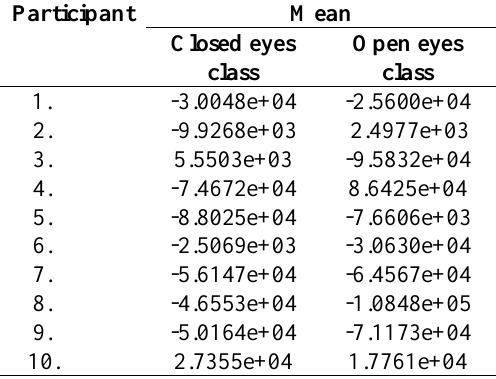
Table 2, The mean values for all